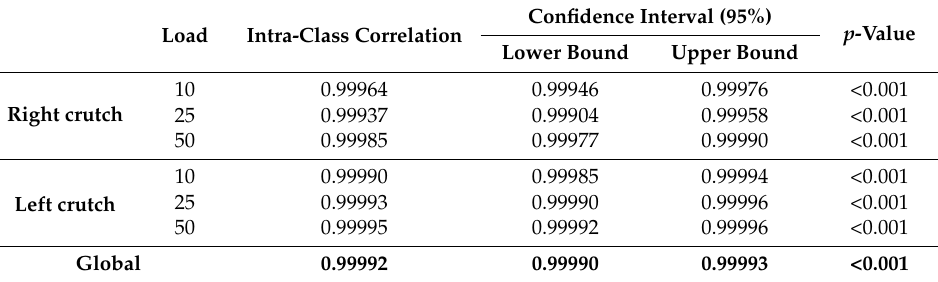
Table 3. Intra-class correlation coefficients between Platform and GCH.